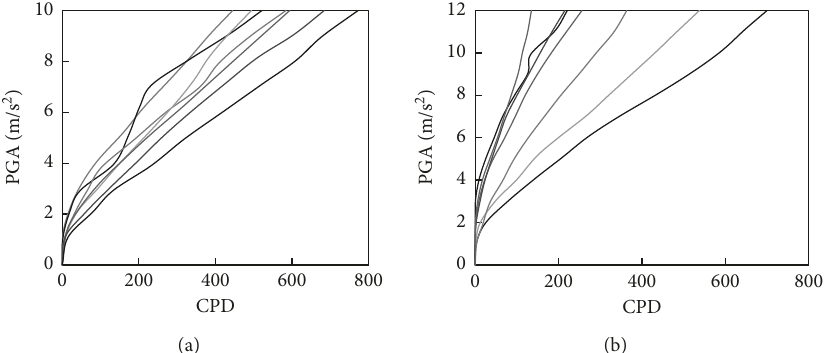
Figure 11: IDA curves of the CPD of a BRB: (a) response to near-fault ground motion; (b) response to far-fault ground